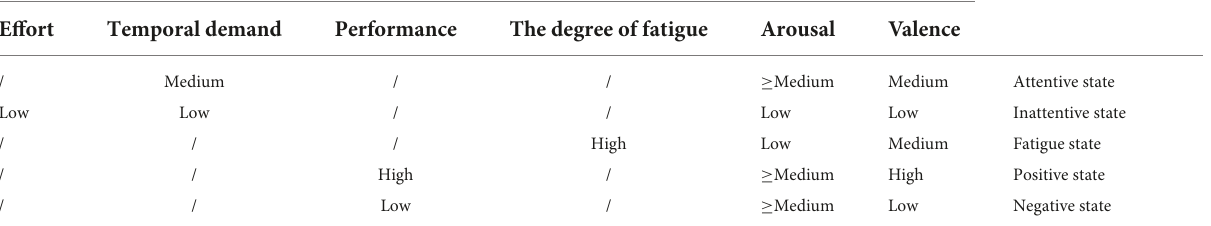
TABLE 1 Correspondence between the indicators parameters and typical mental states in the subjective evaluation